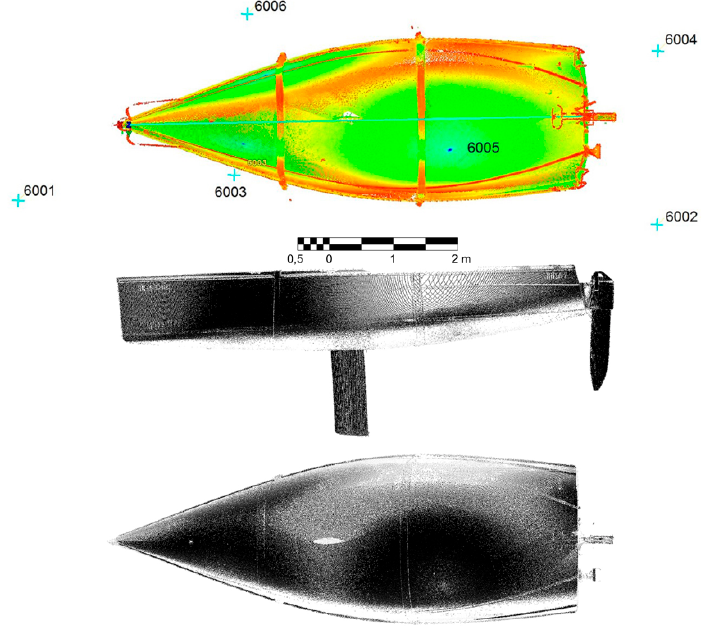
Figure 11. Up—positions of the laser scanner in the 2nd stage; down—the final point cloud.